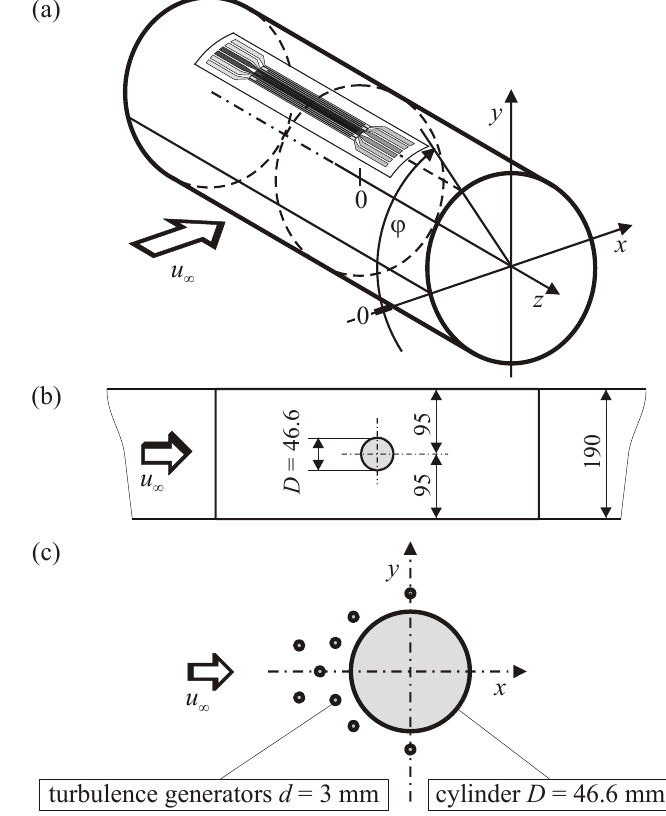
Figure 7. Test case geometry of the circular cylinder in cross flow. (a) Position of the triple sensor measured by  . (b) Wind tunnel test section with the circular cylinder. (c) Upstream turbulence generators (drawn to